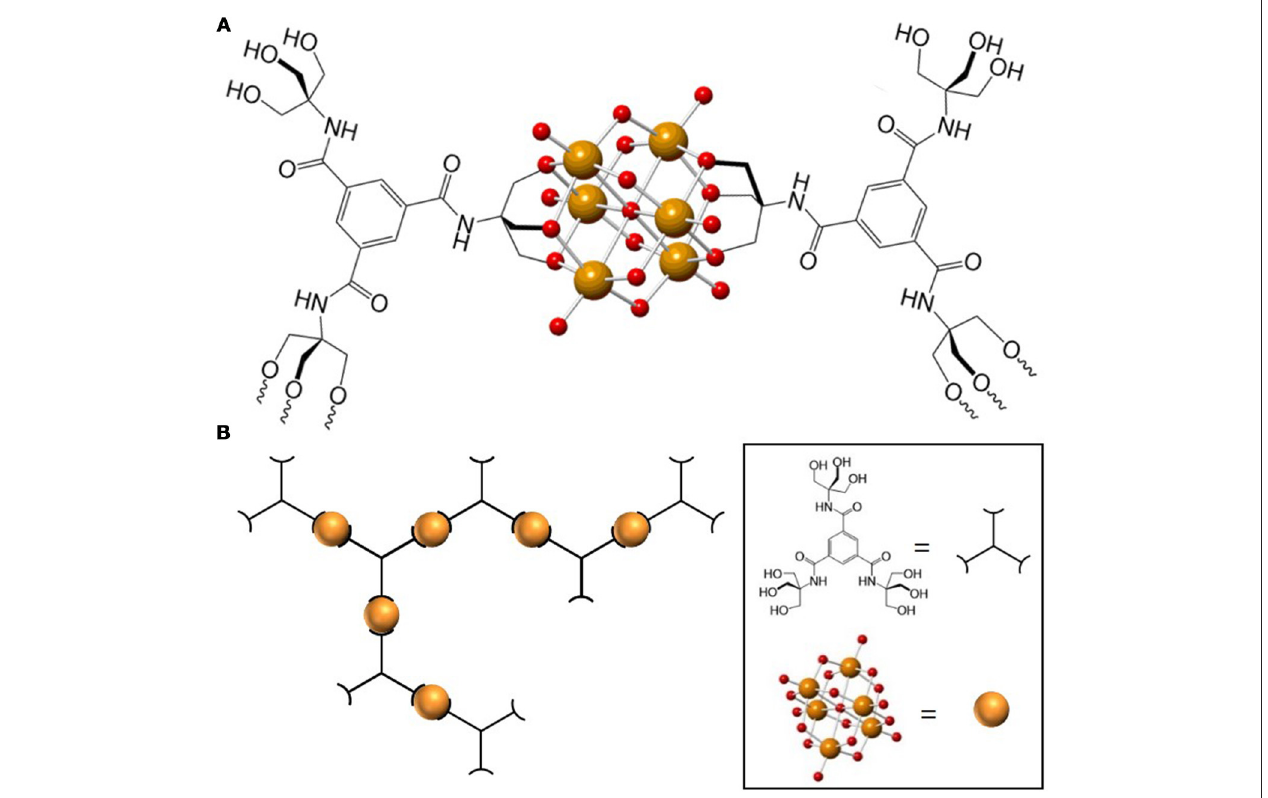
FIGURE 2 | ( A ) Representation of a monomeric TBA-polyV 6 unit. ( B ) Representation of the TBA-polyV 6 polymer. Orange and red spheres represent V(V) and O 2 − , respectively. Reproduced from (Sullivan et al., 2017) with permission from the Royal Society of Chemistry.